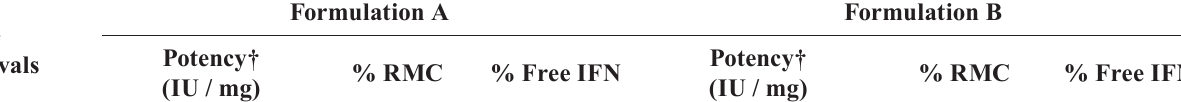
TABLE III - Peginterferon alfa-2b in two different buffer systems: exposed to different temperature conditions